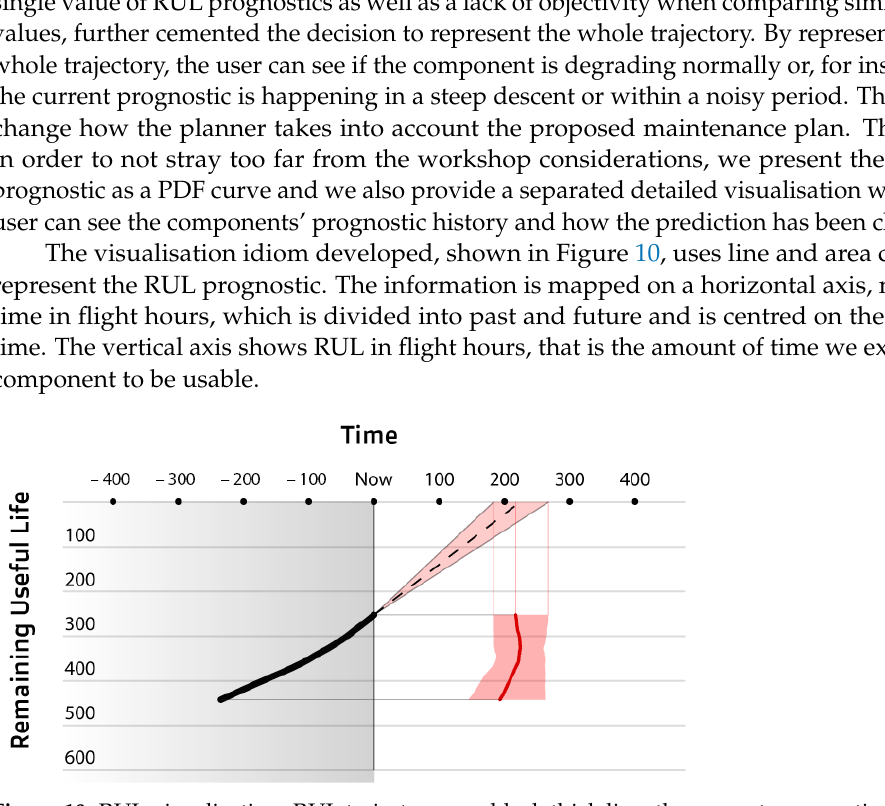
Figure 10. RUL visualisation: RUL trajectory as a black thick line; the current prognostic is shown by the red triangle and the dashed line starting at the end of the black trajectory. The dashed line can show RUL in single value or the mean of a PDF. The width of the triangle marks one standard deviation away from the mean or a minimum and maximum RUL; the red area in the lower right zone represents the Expected End of Life (EEoL) according to each RUL